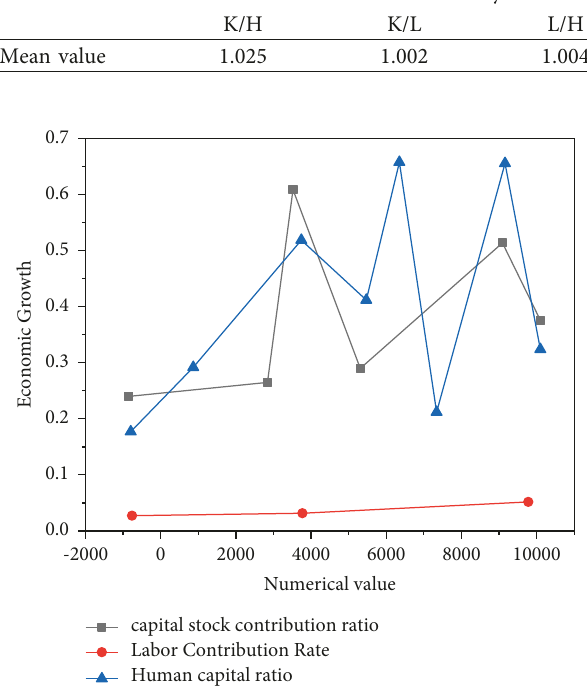
Figure 2: Contribution rate of various factors to economic